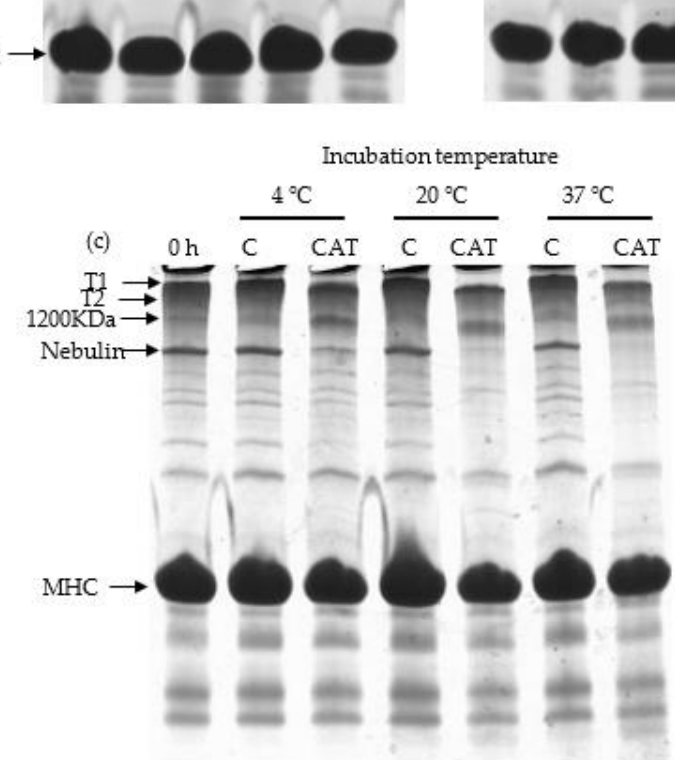
Figure 1. SDS-PAGE patterns of Coomassie-stained 5% continuous polyacrylamide gel, indicating the degradation of titin and nebulin by cathepsin L in vivo and in vitro. ( a ) Samples treated with cathepsin L inhibitor for 0, 1, and 3 day postmortem at 4 ◦ C in vivo; ( b ) samples treated with cathepsin L inhibitor for 0, 7, and 14 day postmortem at 4 ◦ C in vivo; ( c ) samples incubated with cathepsin L for 10 h at 4, 20, and 37 ◦ C in vitro. Abbreviations are as follows: T1 = intact titin; T2 = degradation product of intact titin; MHC = myosin heavy chain; C = control; CAT = cathepsin L; CATI = sample incubated with cathepsin L inhibitor.